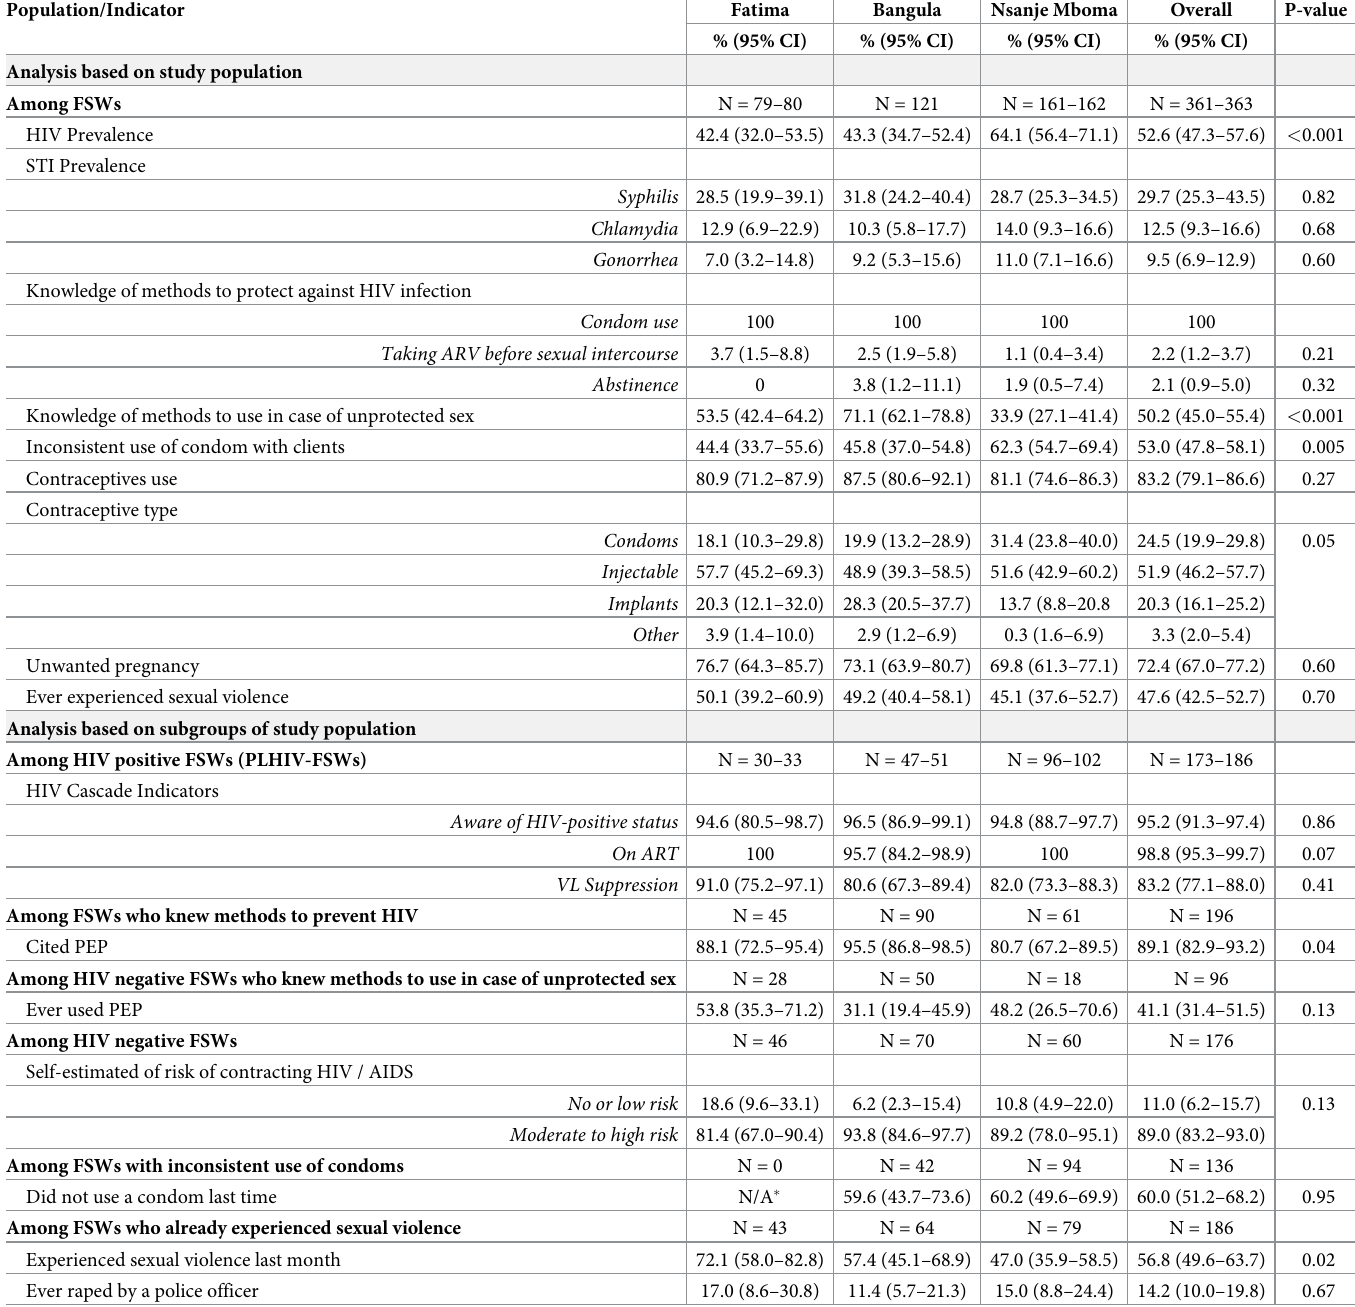
Table 3. Weighted RDS estimates of key study